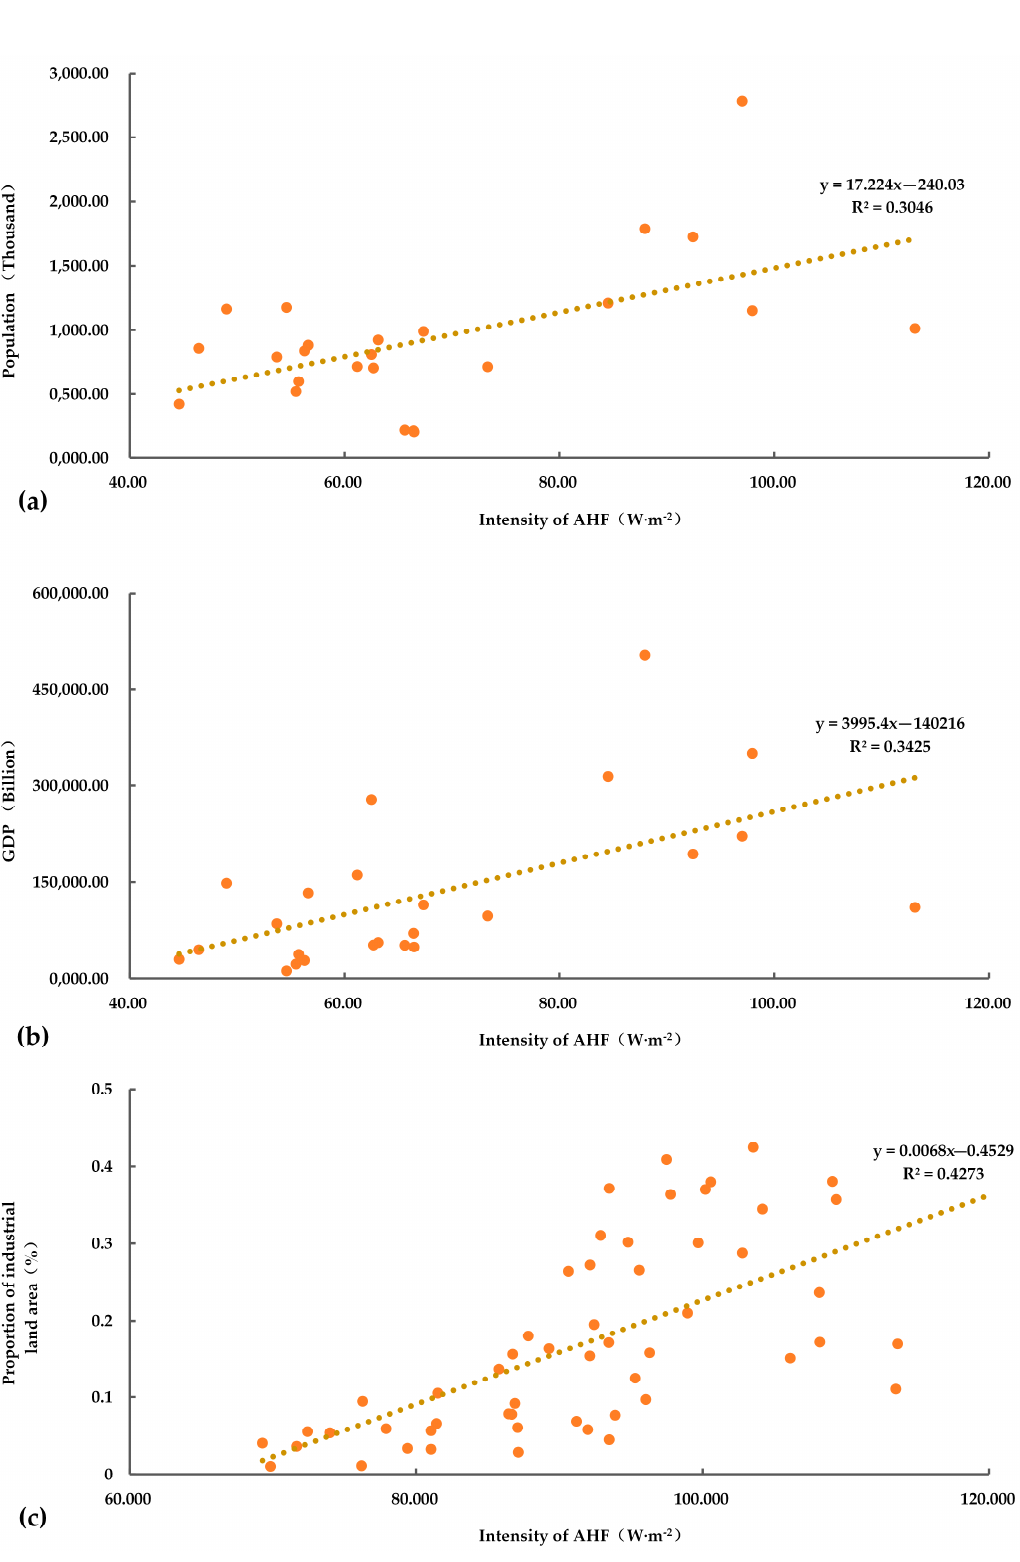
Figure 7. Fitting functions of anthropogenic heat emission intensity with ( a ) population, ( b ) GDP, and ( c ) proportion of industrial land.